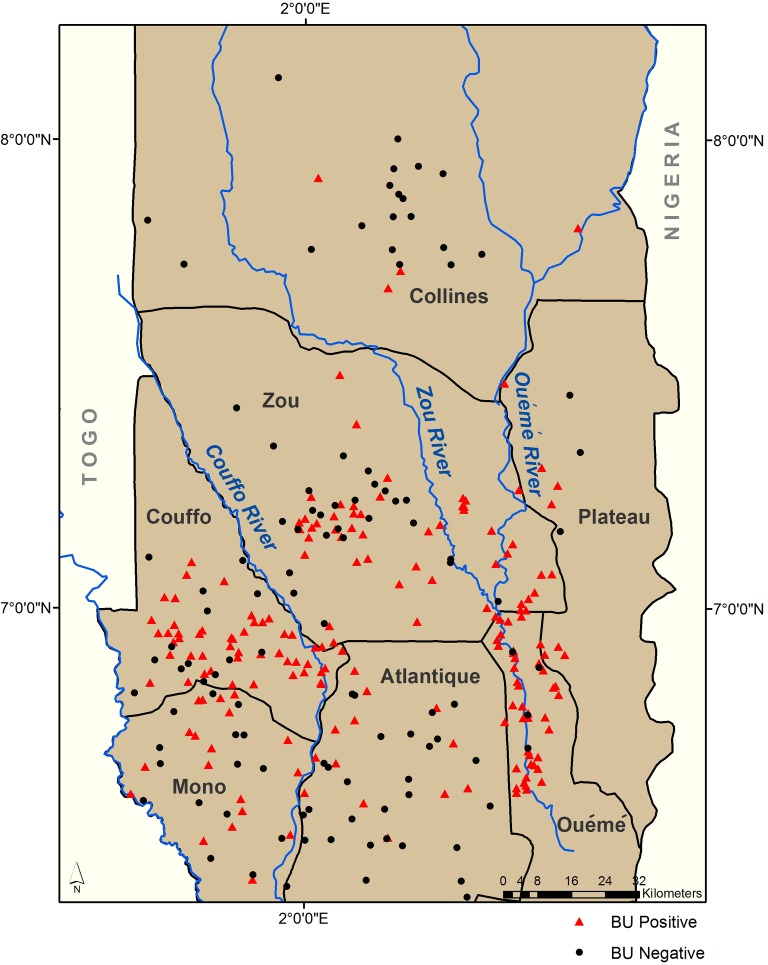
BU positive and BU negative community locations.